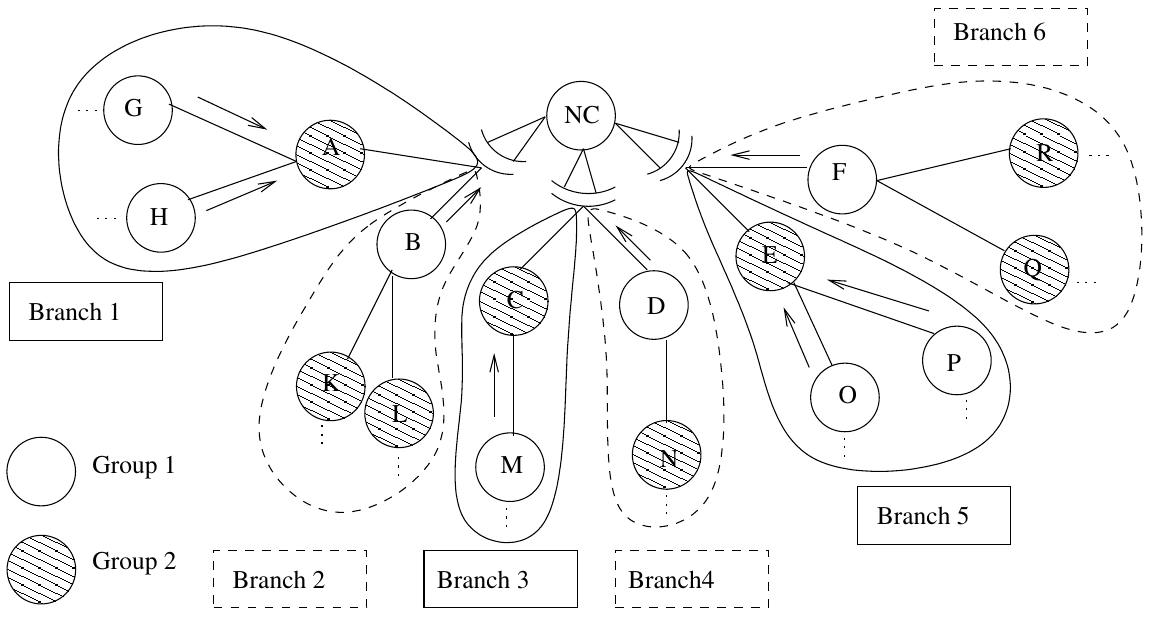
Figure 3. Network segmentation. Each interface divides its descendants into two branches.